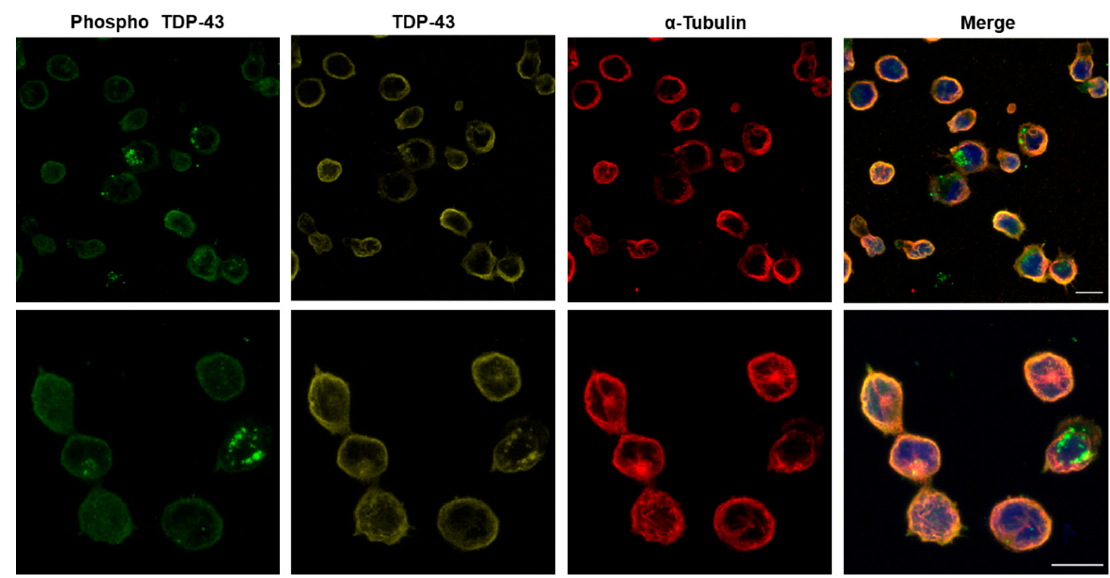
Figure 9. Phospho TDP-43, TDP-43 and α - Tubulin are simultaneously stained with QD-Ab2 emitting at 565, 605 and 655 nm, respectively in a sporadic ALS patient. Nuclei were stained with HCS Nuclear Mask Deep Red. Scale bar: 20 µm.